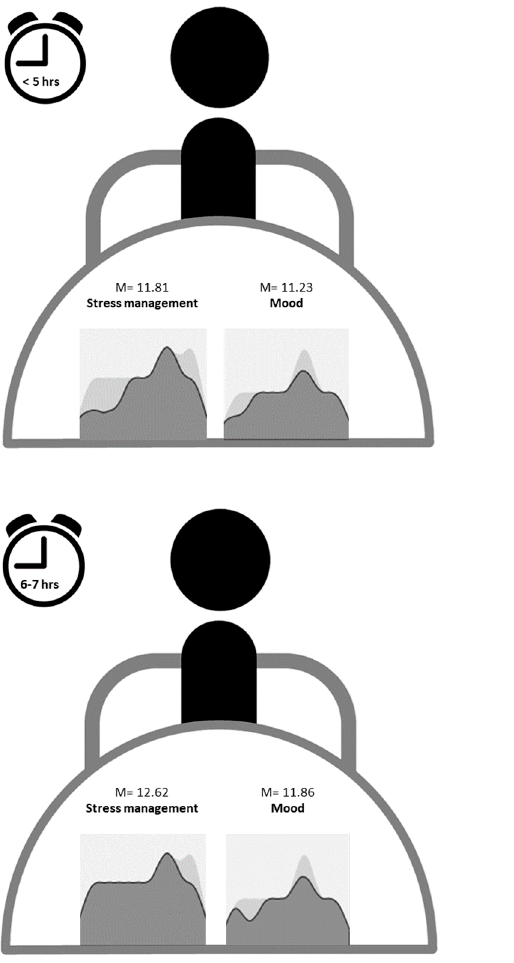
Figure 1. Sleep patterns by duration and mean scores in stress management and mood.